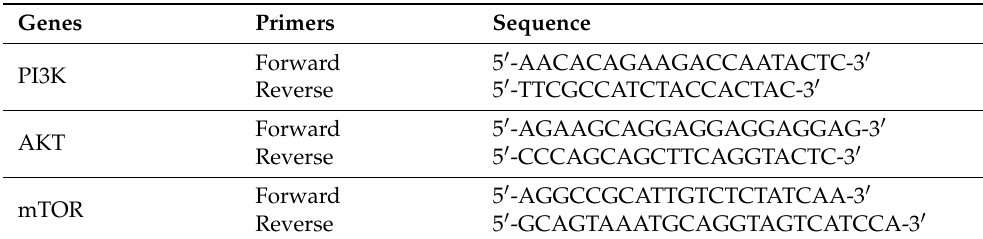
Table 1. List of primers utilized in the